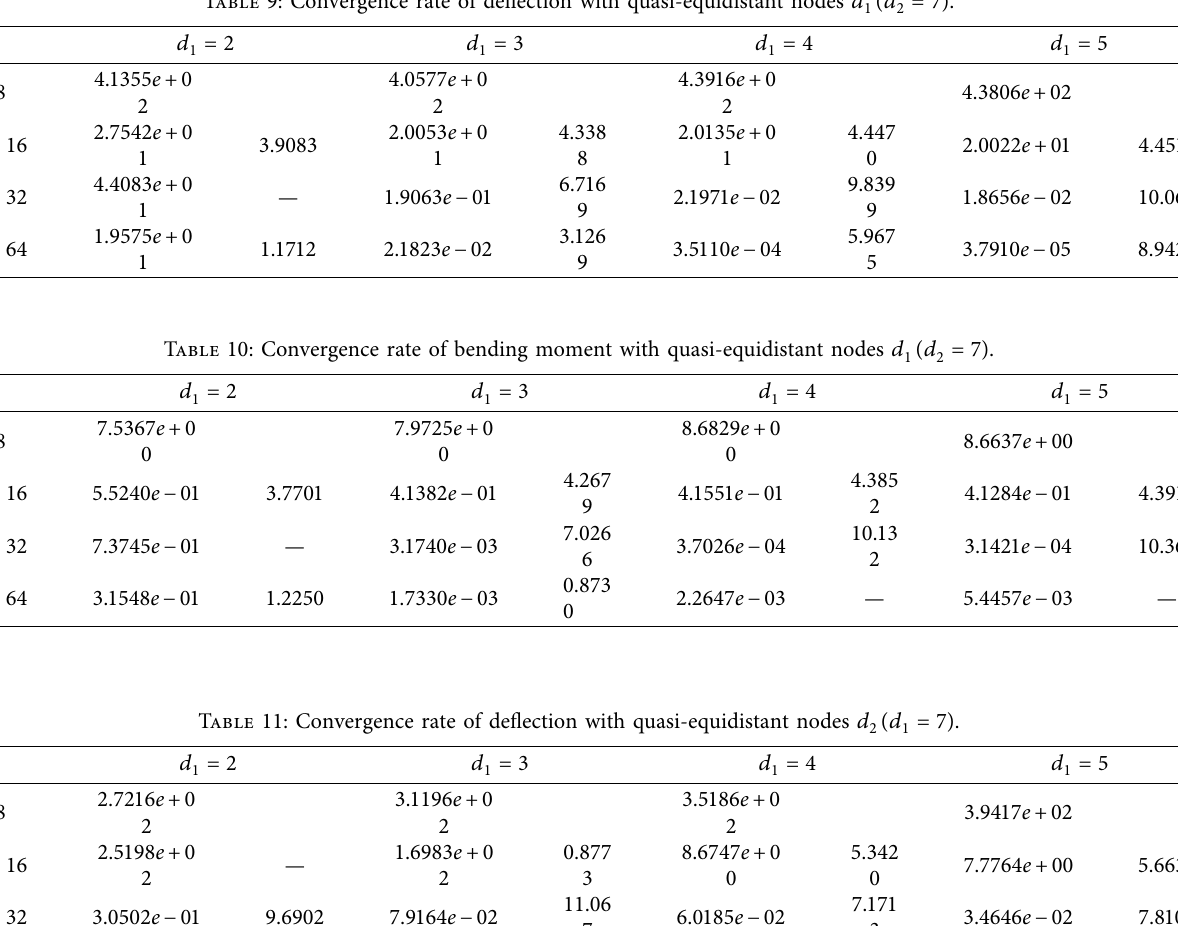
Table 9: Convergence rate of deflection with quasi-equidistant nodes d